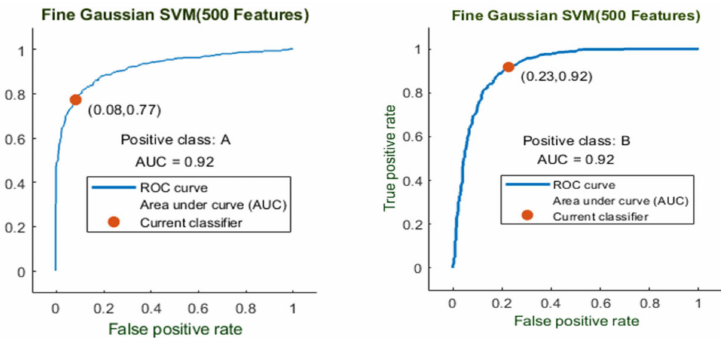
Figure 19. ROC curve for two classes A and B with 500 features and using 10-fold